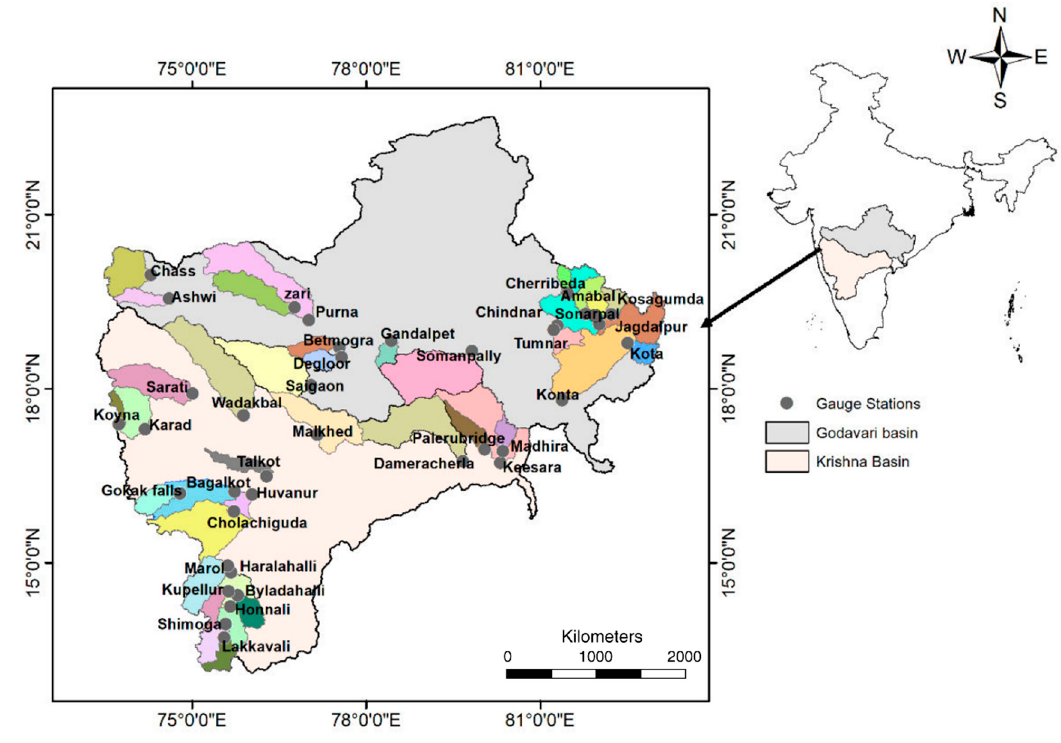
Figure 1. Map showing the locations of the 40 study basins considered for evaluating the two FDC models.